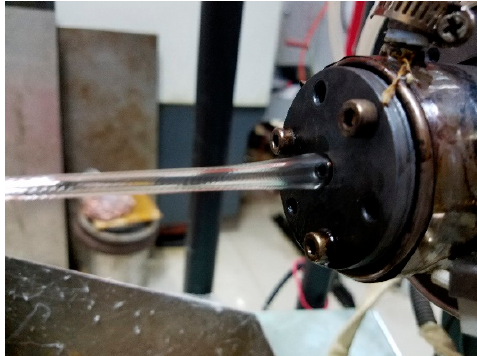
Figure 12. Micro-tube formation under 100 Pa.